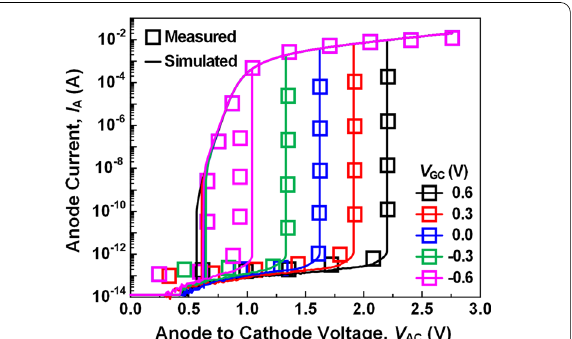
Fig. 2 I A ‑ V AC characteristics for various V GC s simulation results (lines) adjusted to the experimental data (symbols) of the p + silicon memory device with a gated